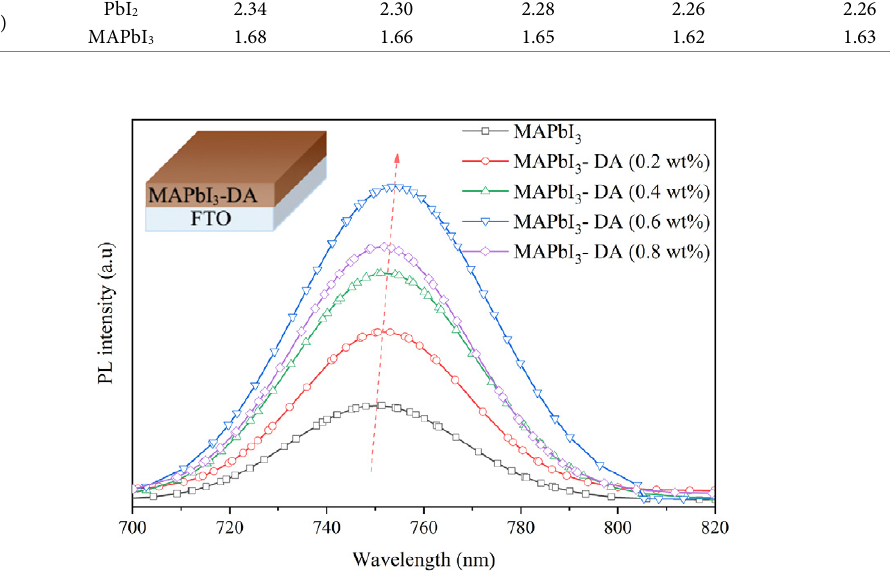
Fig. 4. Steady state photoluminescence (PL) spectra of MAPbI 3 films doped with various concentrations of DA deposited on top of FTO